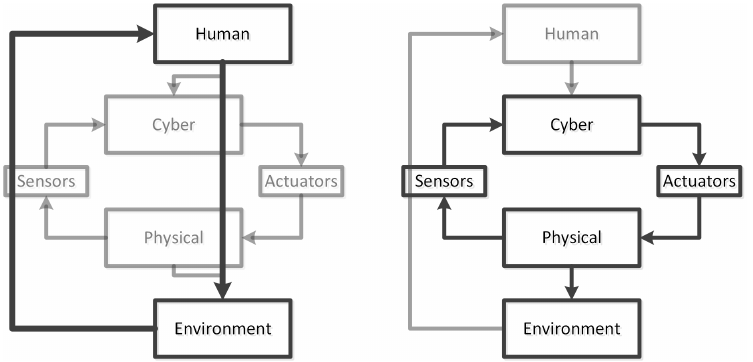
Figure 3. Embodiment vs.